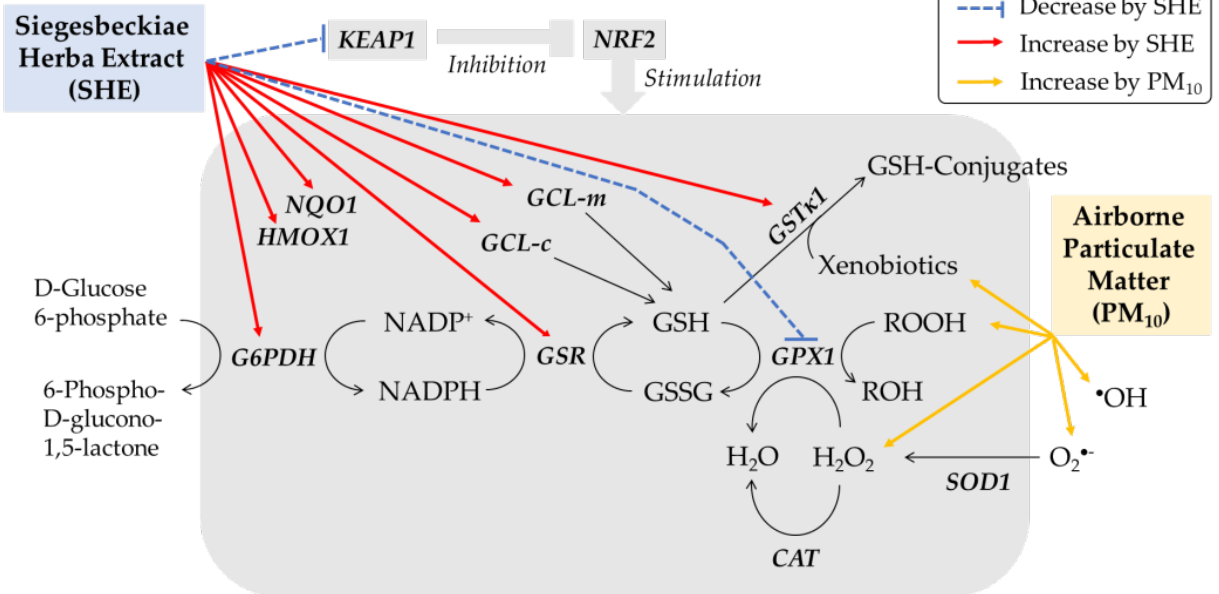
Figure 12. Working model for the protective effects of SHE against PM 10 -induced oxidative stress in HaCaT keratinocytes. PM 10 increases ROS, such as superoxide radical (O 2 •− ), hydrogen peroxide (H 2 O 2 ), and hydroxyl radical ( • OH), and lipid peroxide (ROOH), causing oxidative stress and death of HaCaT cells. SHE does not change the mRNA expression of NRF2, but decreases that of KEAP1, a negative regulator of NRF2, leading to the activation of NRF2 to induce the expression of target genes, such as HMOX1 and NQO1. SHE selectively induces the enzymes involved in the synthesis of GSH (GCL-c and GCL-m), the regeneration of GSH (GSR and G6PDH), and GSH conjugation of xenobiotics (GST κ 1), rather than the enzymes that directly scavenge ROS (SOD1, CAT, and GPX1). SHE increases the cellular content of GSH and mitigates the oxidation of GSH to GSSG caused by PM 10